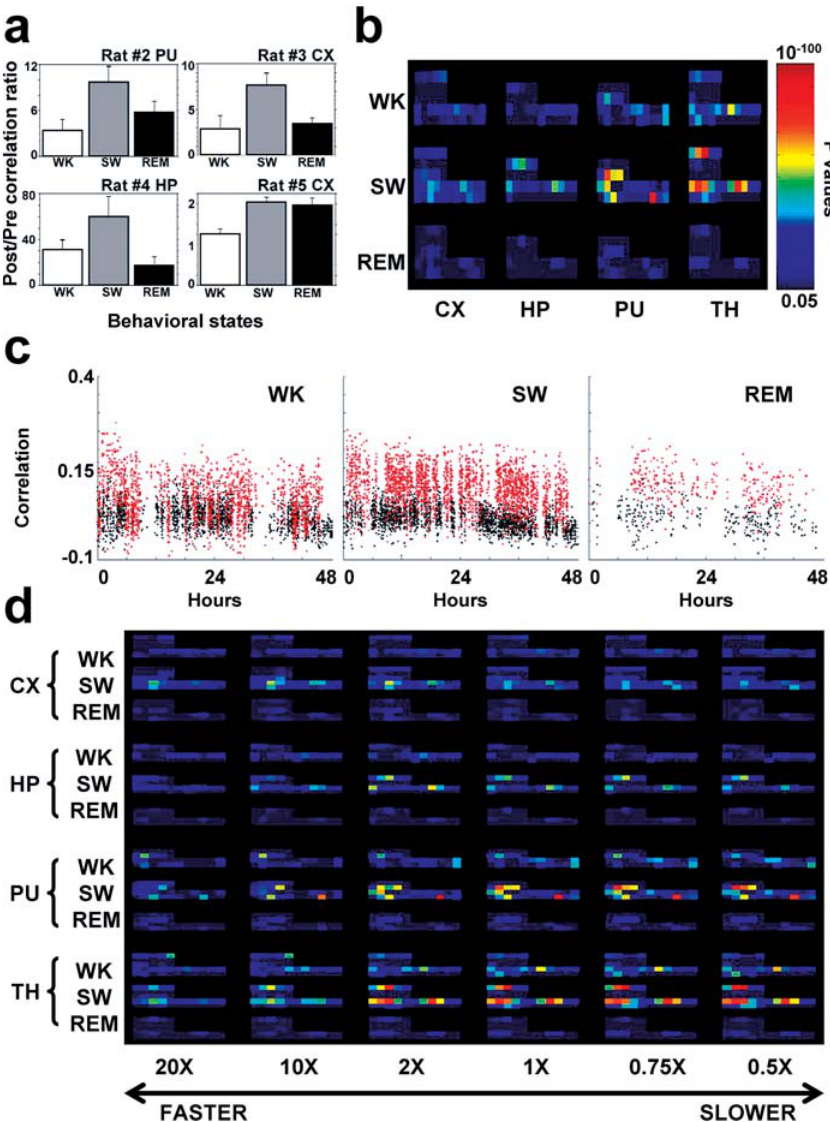
Figure 4. Neuronal Reverberation De- pends on Behavioral